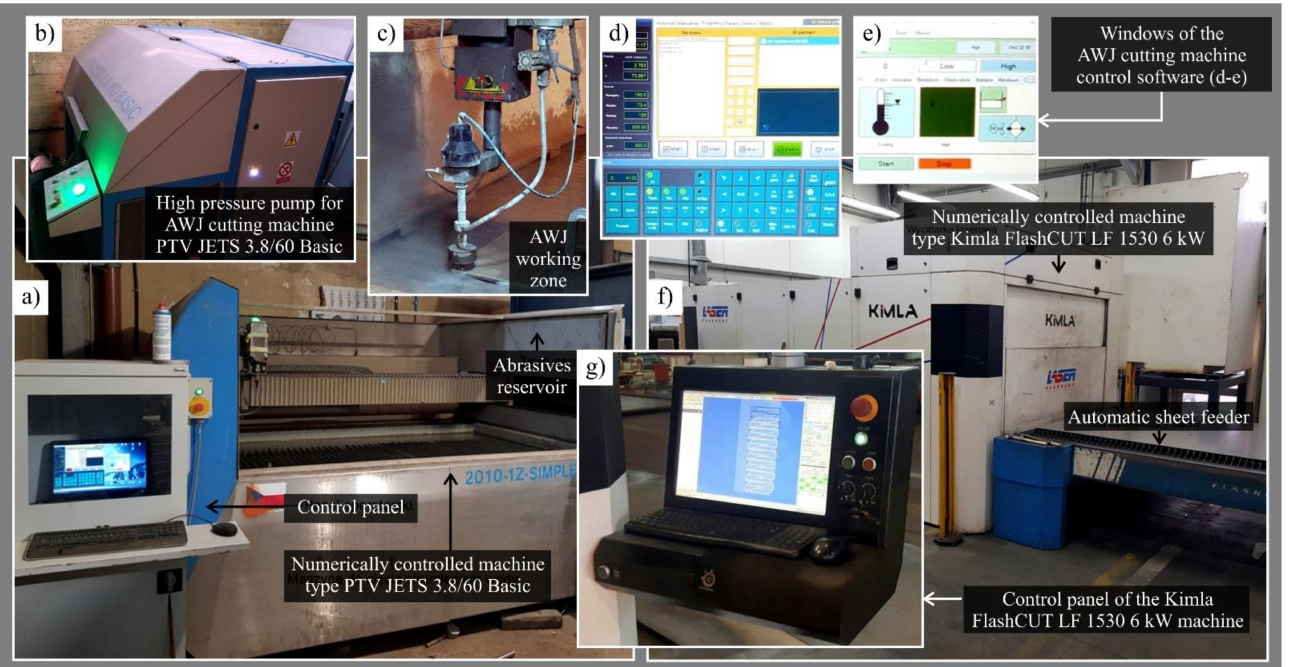
Figure 1. Experimental positions used in the study: ( a ) general view of numerically controlled AWJ cutting machine Kimla FlashCUT LF 1530 6 kW (Kimla, Cz˛estochowa, Poland); ( b ) view of the high pressure pump for AWJ cutting machine; ( c ) view of the AWJ cutting head; ( d , e ) windows of the AWJ cutting machine control software; ( f ) general view of numerically controlled laser cutting machine type PTV JETS 3.8/60 Basic (PTV, Hostivice, Czech Republic); ( g ) view of the laser cutting machine control